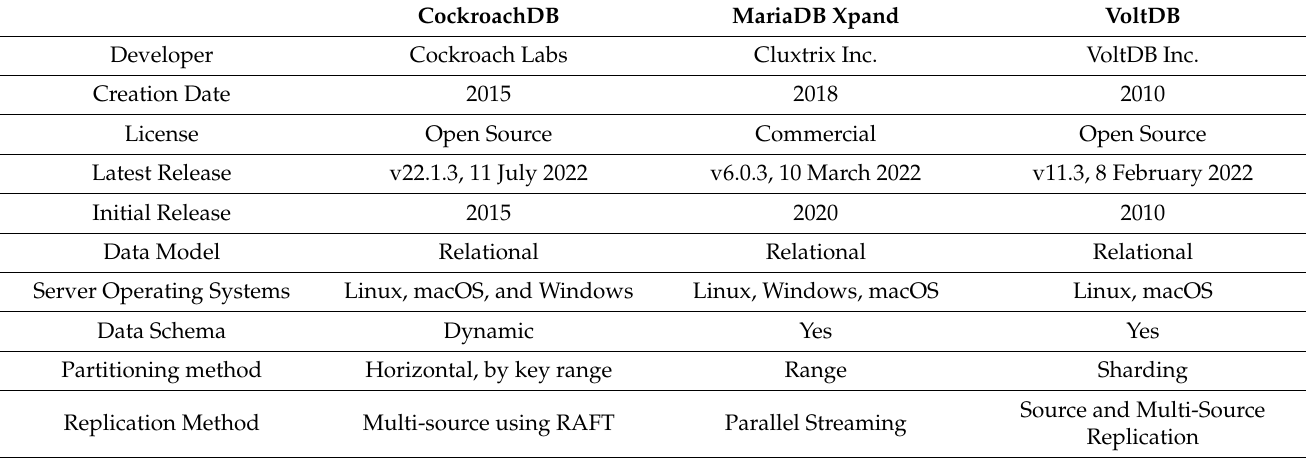
Table 1. NewSQL databases